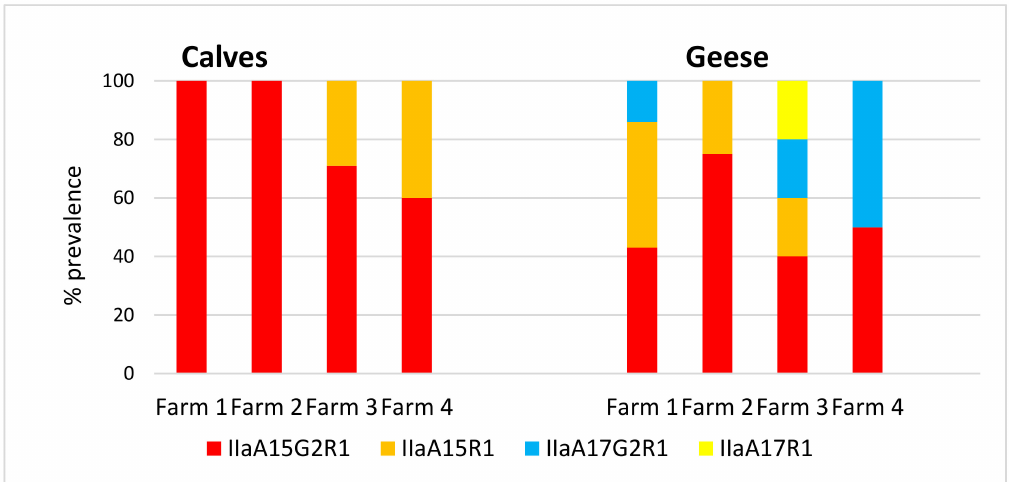
Figure 3. Percentage of C. parvum -positive samples with each identified genotype present in calf and goose